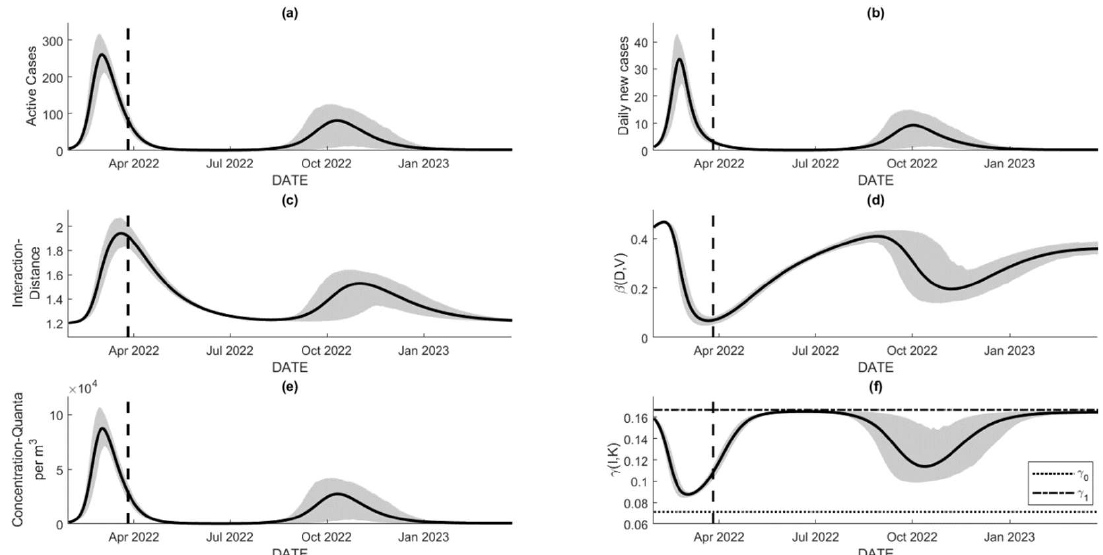
Figure 7. The extrapolated figures with the dashed line initiate the prediction window. The figures were evaluated using the estimated parameters obtained in the previous section, with the assumption of no significant change in parameters for the 365-day prediction intervals: ( a , b ) extrapolated number of active cases and daily new cases that levels off in around May to July 2022, but starts to increase on August and peaks on October 2022, ( c ) average interaction distance of society that will approach its natural distancing of D ∗ = 1.2 m as the number of cases decreases, but increases when the case resurgence is identified, ( d ) time-dependent transmission rate that gradually increasing as D approaches D ∗ , ( e ) dynamic for viral load over time that resembles that for active cases, and ( f ) time-dependent recovery rate that its values are bounded by γ 0 and γ 1